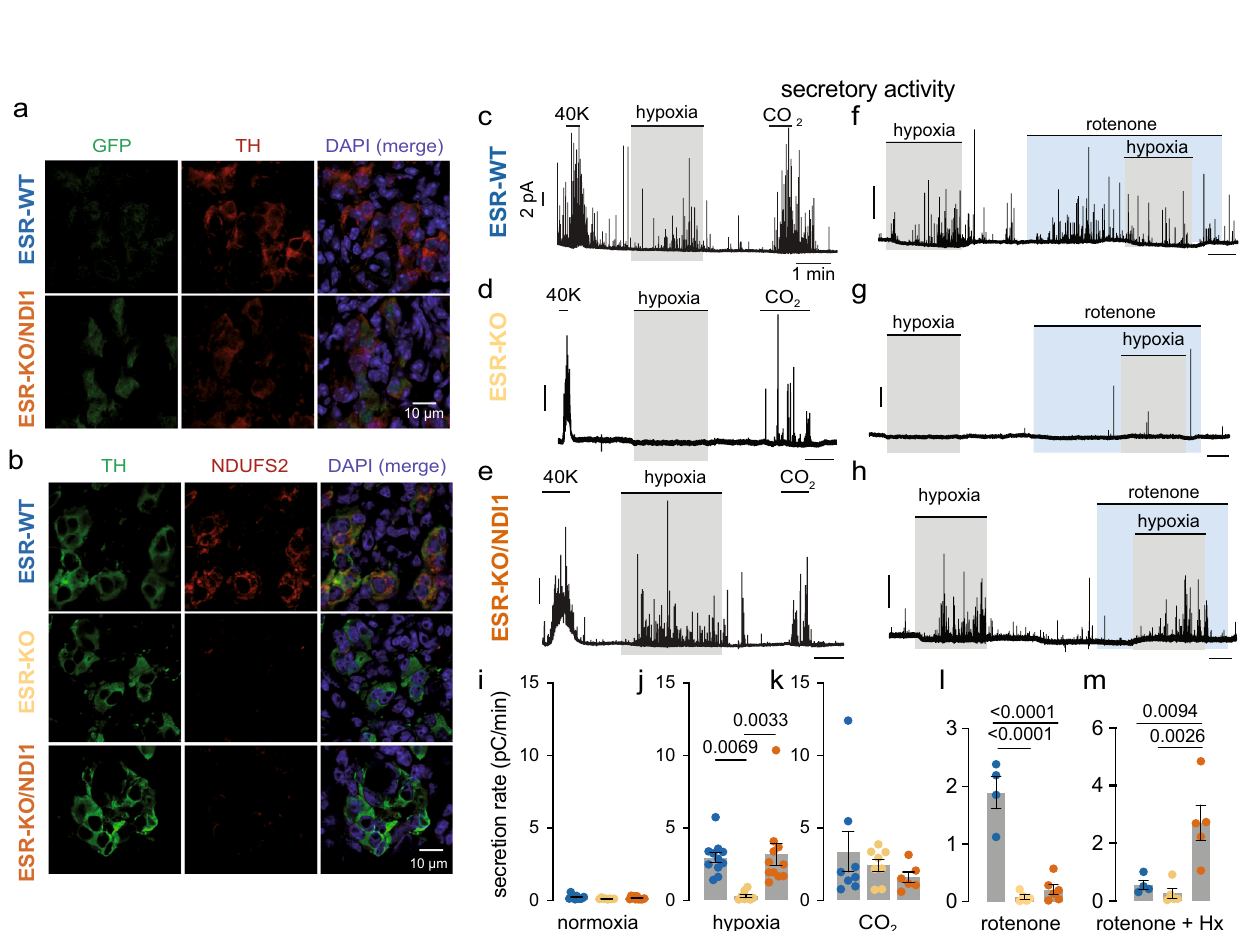
Fig. 6 | Rescue of the hypoxic ventilatory response in mitochondrial complex I-de fi cient mice by conditional transgenic NDI1 expression in adulthood. a Schemeillustratingthetimecourseoftamoxifen(TMX)treatmenttogeneratethe adult ESR-KO (top) and the ESR-KO/NDI1 (bottom) mice. The age at which mice were used for experiments is indicated. Note that whereas all ESR-KO mice died before 50 days after termination of tamoxifen treatment, lifespan was clearly increase in ESR-KO/NDI1 mice ( b – d ), Hypoxic (10% O 2 ) ventilatory response (HVR, breaths/min) of the mouse strains studied (ESR-WT, n =10; ESR-KO, n =9; ESR-KO/ NDI1, n=13). Changes in O 2 tension (%) with time are represented at the bottom. Each data point is represented as mean±SEM. Time calibration bar in ( b ) (5min) also applies to ( c , d ). e – g Hypercapnic ventilatory response (5% CO 2 , breaths/min) of the mouse strains studied (ESR-WT, n =7; ESR-KO, n =9; ESR-KO/NDI1, n =12). Changes in % CO 2 with time are represented at the bottom. Each data point is